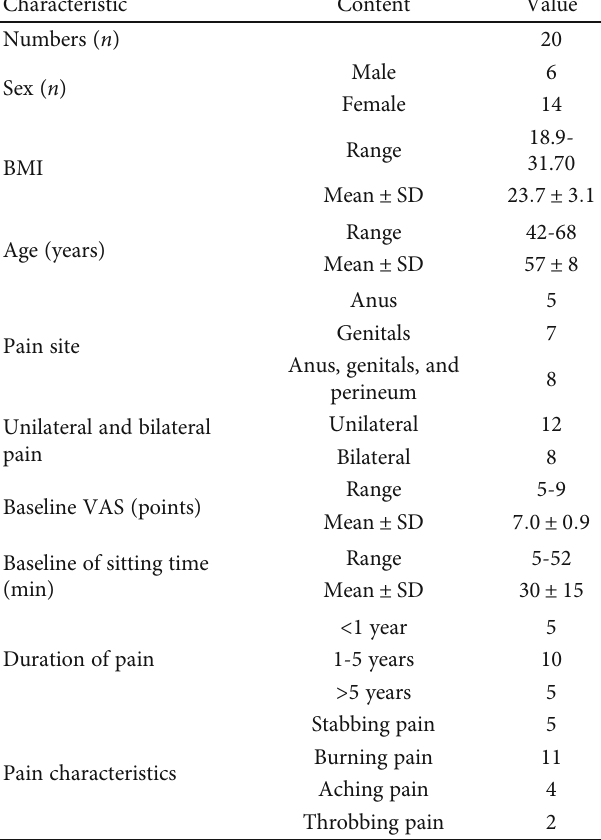
Table 3: Demographic characteristics of patients.